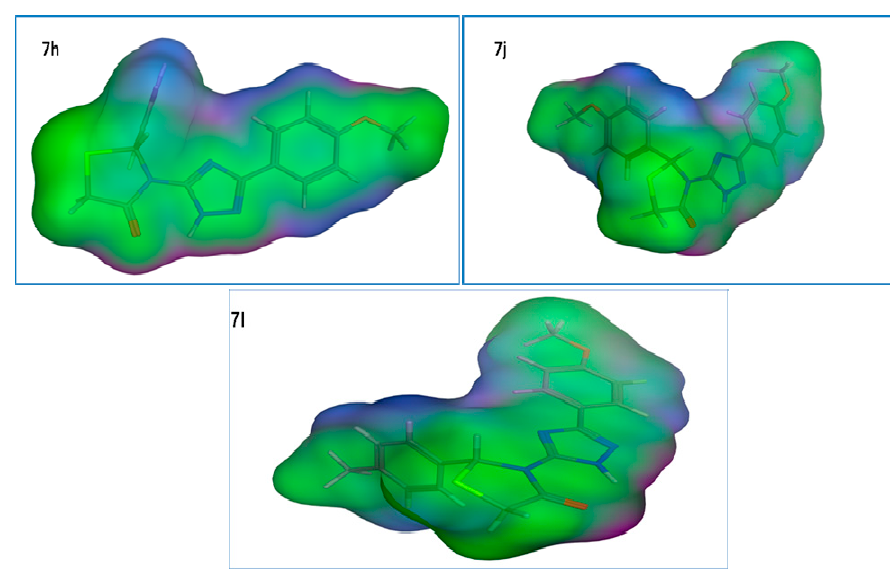
Figure 8. Surface map for the MurB active site with the docked conformation of Compound 7h (red stick) (pink: hydrogen bond; blue: mild polar; green: hydrophobic region).